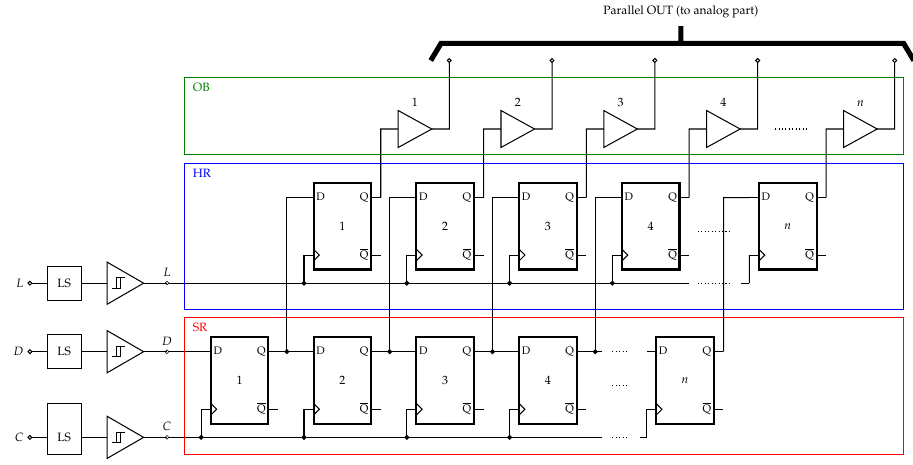
Figure 2. n -bit SIPO interface.